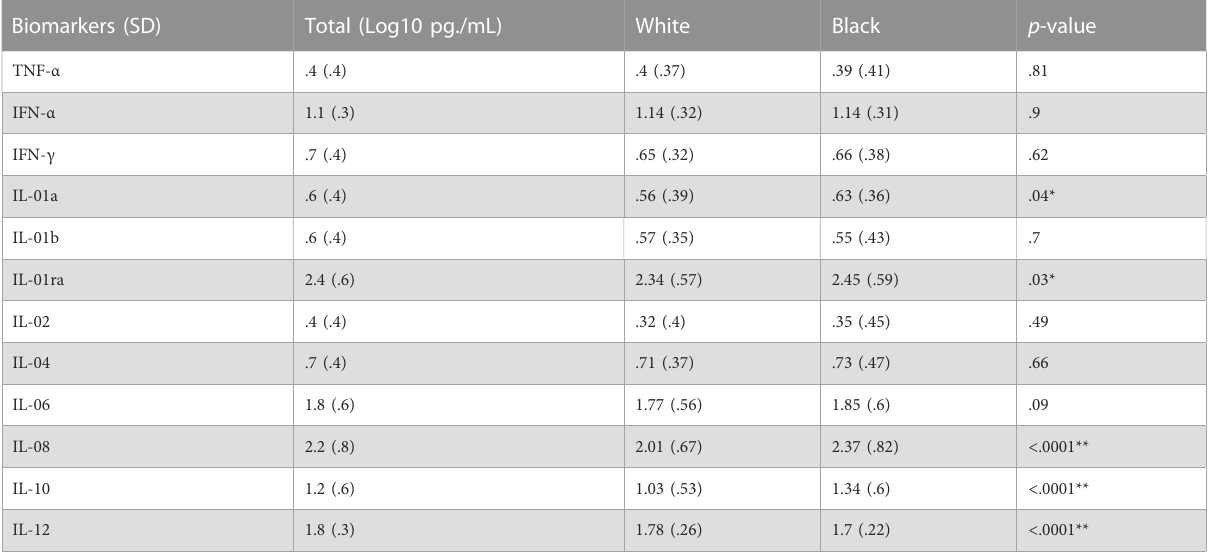
TABLE 3 Biomarkers by